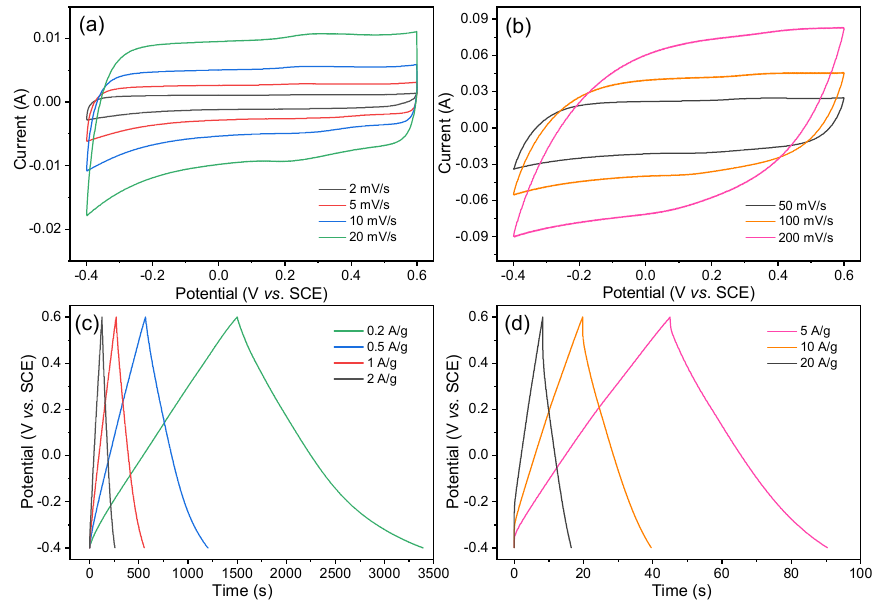
Figure 6. ( a , b ) CV profiles at different scan rates and ( c , d ) GCD curves at different current densities for BC-24.